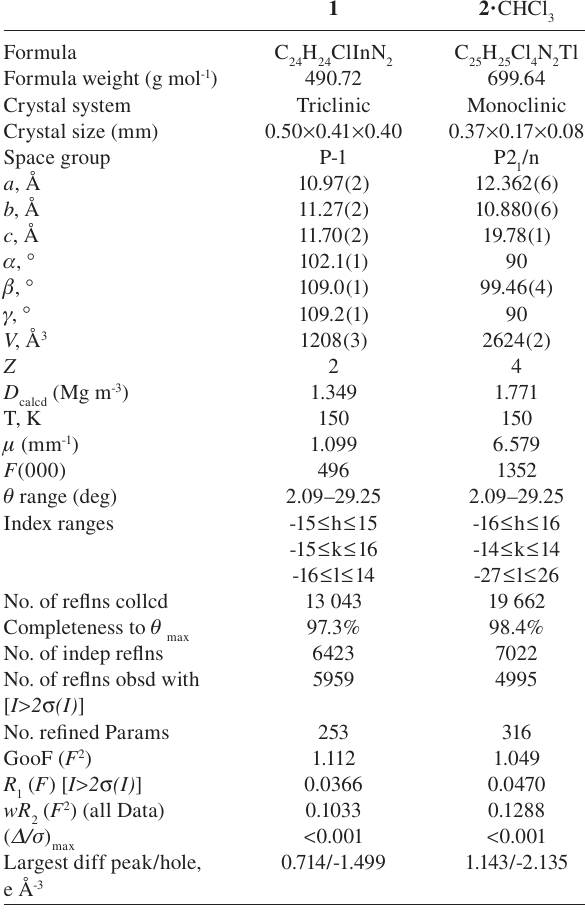
Table 1 Crystal data and structure refi nement for 1 and 2 .